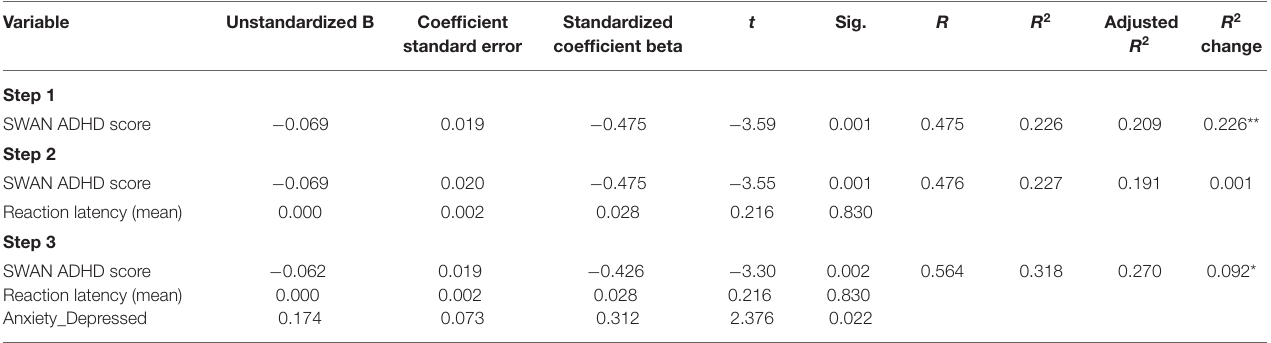
TABLE 14 | Regression model of the AST reaction latency and the CBCL Anxiety/Depression subscale scores as the predictors of the CBCL social problem subscale score in the control group.